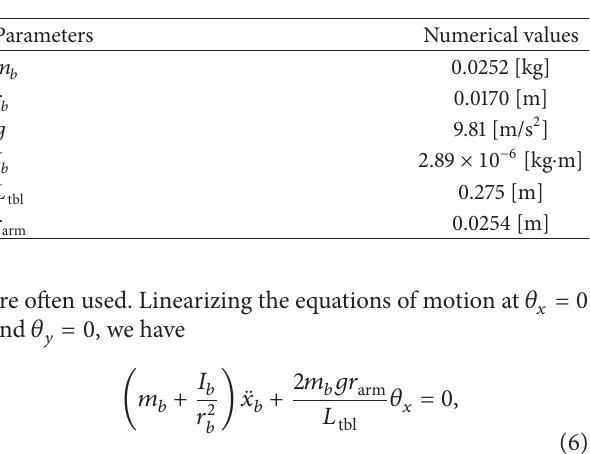
Table 1: Parameters of the ball and plate system.